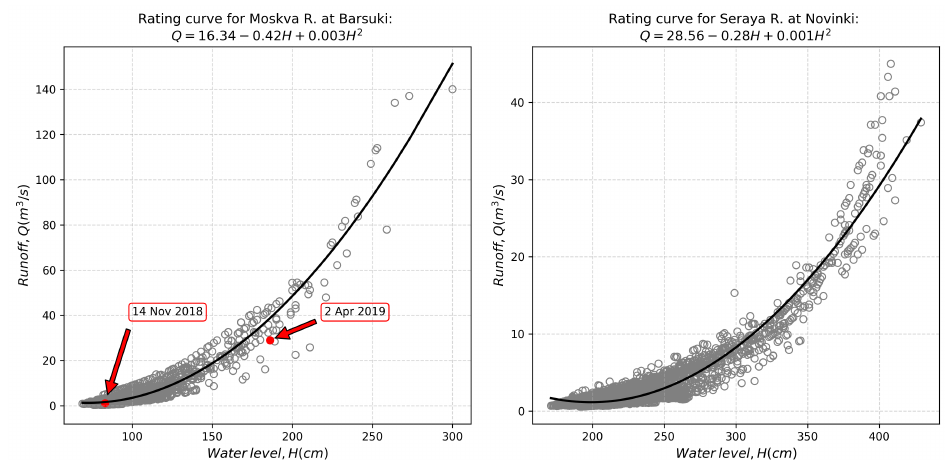
Figure 2. Rating curves for Moskva R. at Barsuki ( left plot ) and Seraya R. at Novinki ( right plot ). Estimated discharge and corresponding water level data for Moskva R. at Barsuki, which has been received during the two field measurement campaigns are highlighted in red